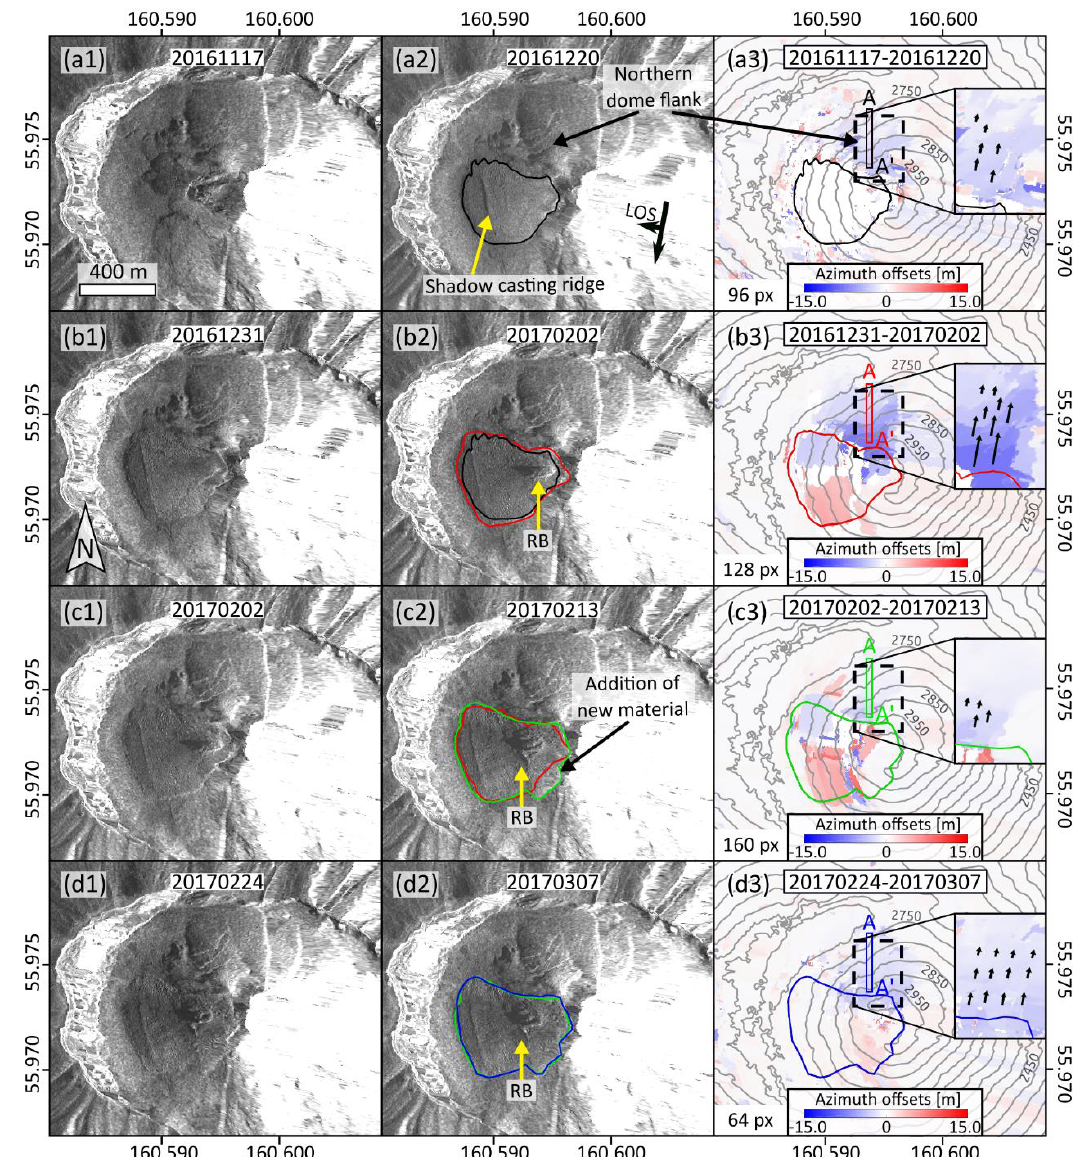
Figure 5. Ground motion detected in TSX amplitude images during the 5 December 2016 – 28 February 2017 effusive eruption. Extent is indicated in Figure 1b. ( a1,2 ), ( b1,2 ), ( c1,2 ), ( d1,2 ) Geocoded TSX amplitude images with indicated changes. Left column are master images, central column are slave images. RB = rigid body. The colour coded outlines show extent of lava flow 1 compared with previous extent. ( a3 – d3 ) Azimuth offset maps and 50 m contour lines of Bezymianny. Red and blue colours reflect movement along (approximately southward) or against (approximately northward) the TSX flight direction (LOS). Employed cross-correlation patches are indicated. Arrows in close-up views indicate relative increase of azimuth displacements from the foot to the summit of the dome. Displacement increases towards the summit. Compare Figure S5 for swath profiles A –A’.